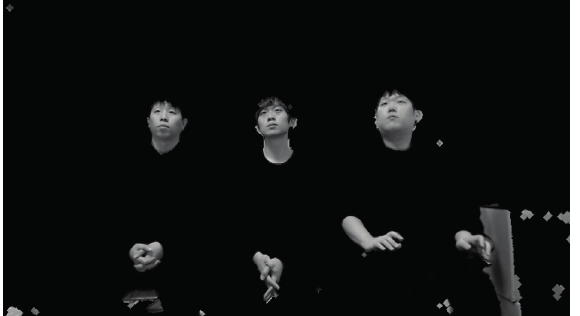
Figure 6. Preprocessed image that contains multiple rotated